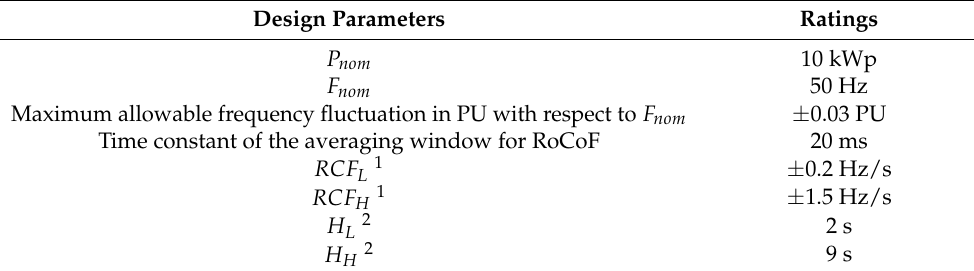
Table 3. Design parameters for DI-based Dynamic Inertia emulation